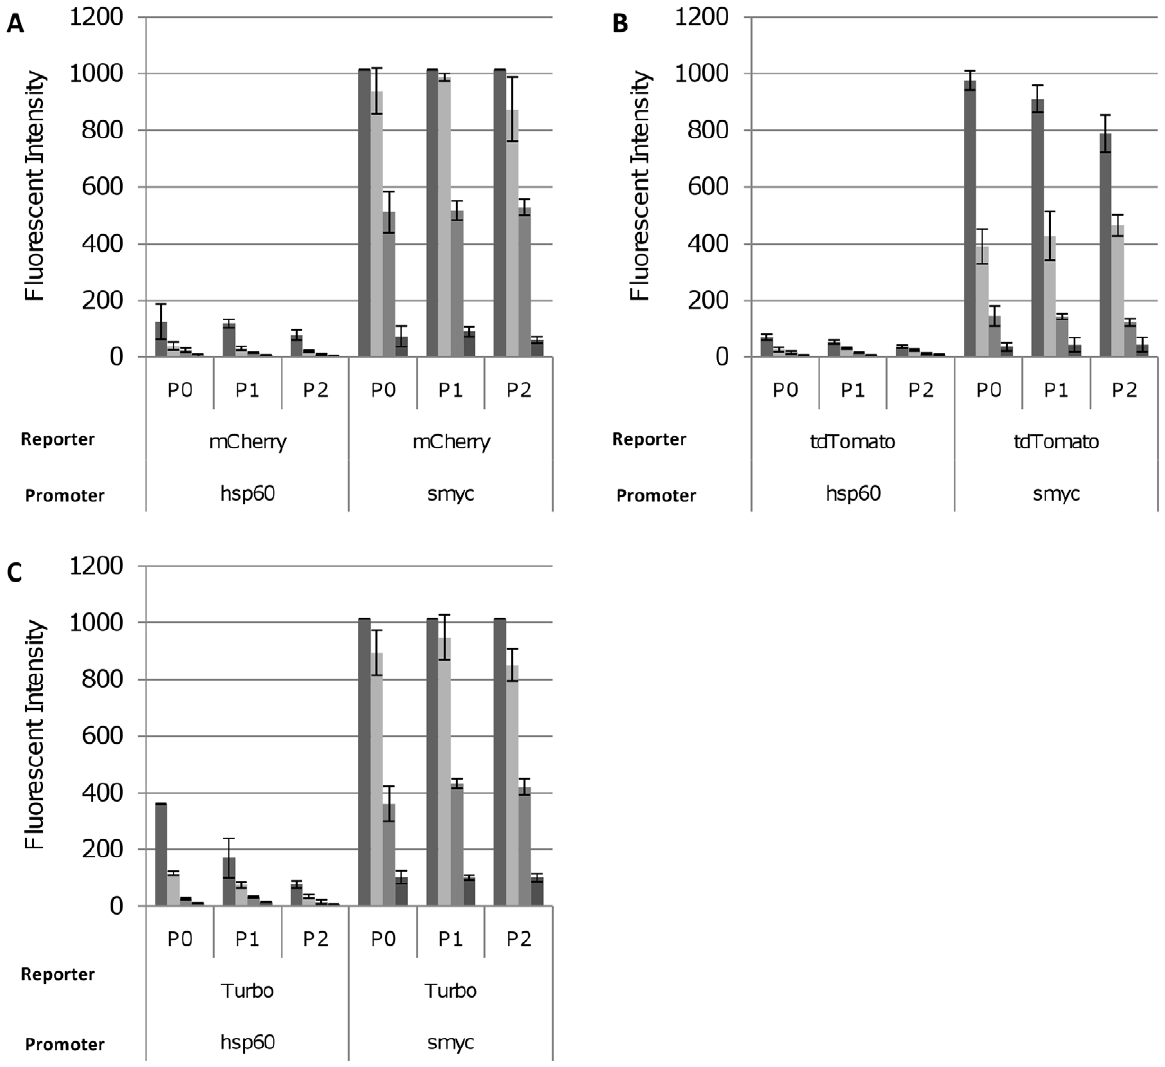
Figure 8. Expression of fluorescent proteins in M.tuberculosis H37Rv is stably maintained. Transformants were grown in liquid medium and passaged every 5 days into fresh medium. Fluorescence was quantified at wavelengths associated with optimum reporter expression and emission at cultures normalised to OD 580 of 0.25, 0.10, 0.05 and 0.01 (from left to right). Fluorescence was quantified at the following wavelengths: mCherry 587/610 nm, tdTomato 554/581 nm, Turbo-635 588/635 nm. Data are the averages and standard deviations from three independent transformants. A value of 1015 corresponds to saturation of the machine. The reporter, promoter and vector backbone are indicated. P0=initial culture; P1=passage 1; P2=passage 2.